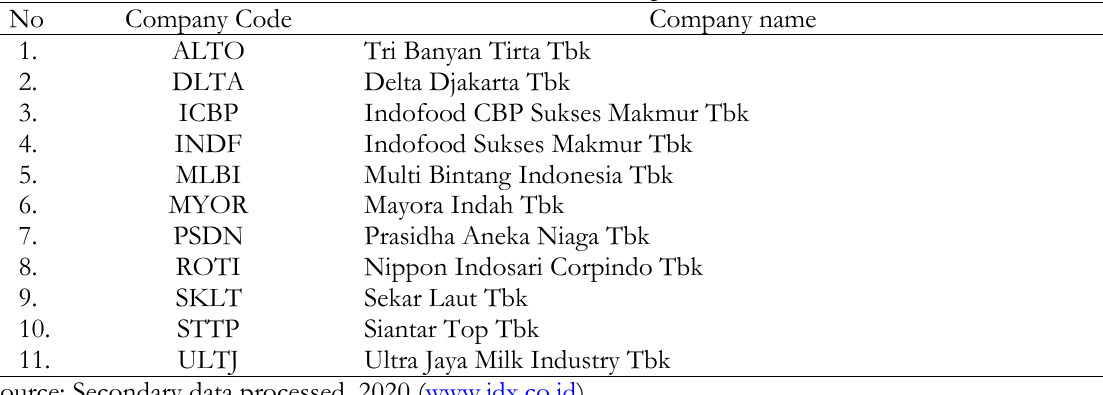
Table 1. Research